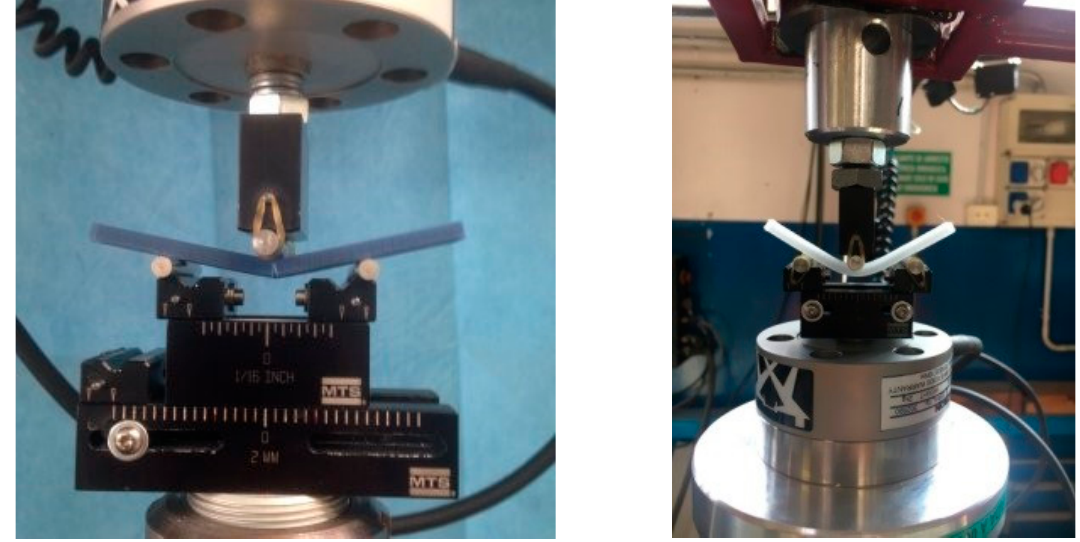
Figure 7. Set-up overview: ( right ) PC sample from sheet, ( left ) ABS sample, both from 3D printing filament material.